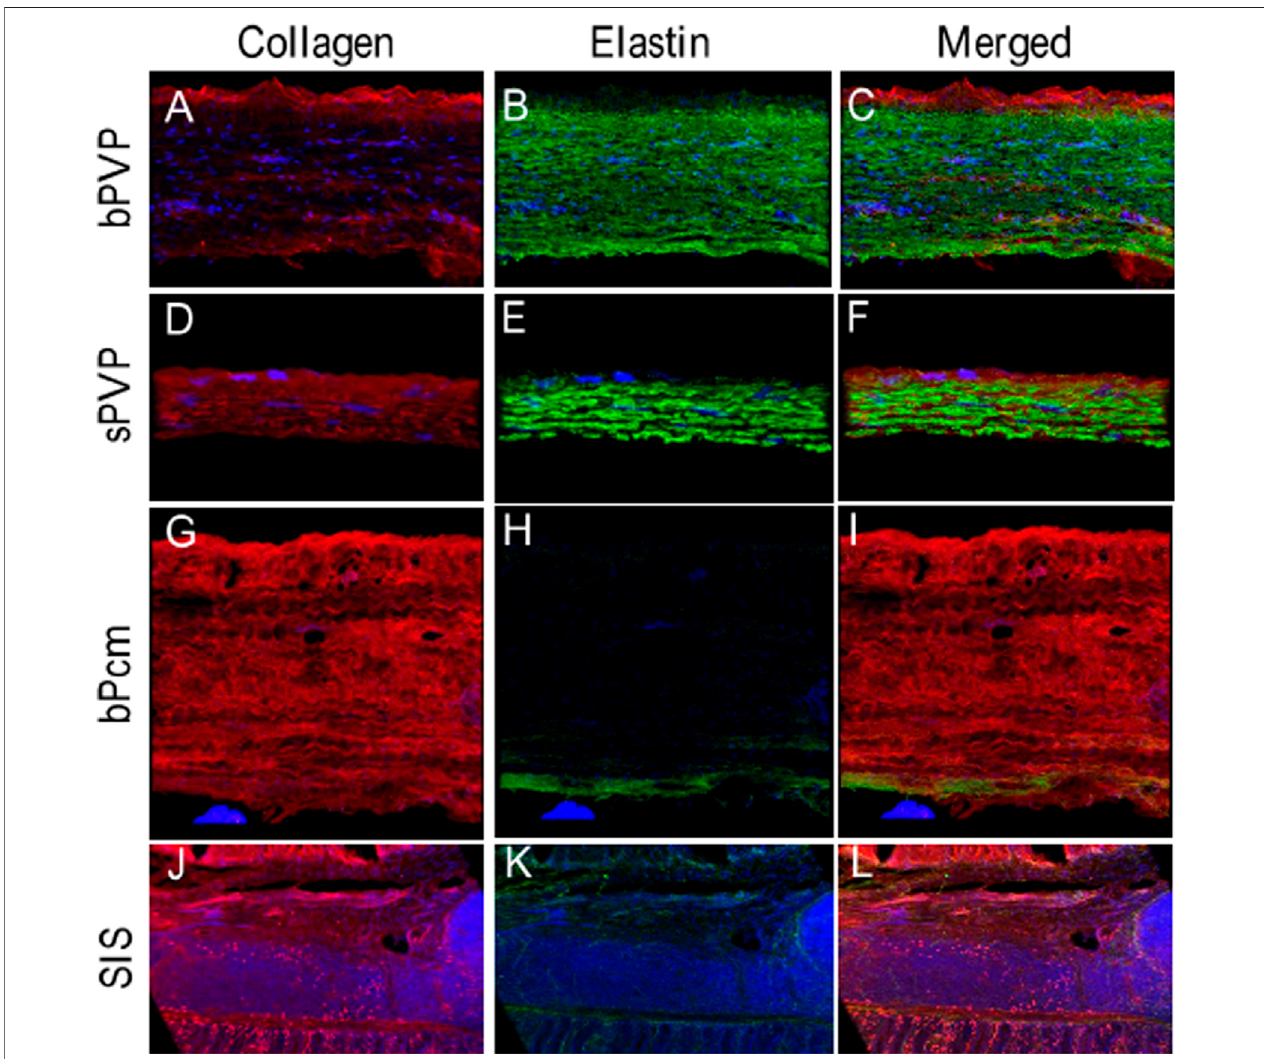
FIGURE 2 | Collagen and elastin fi bers in bPVP, sPVP, bPcm, and SIS. (A – C) Collagen, elastin, and merged collagen and elastin in bPVP, respectively. (D – F) Collagen, elastin, and merged collagen and elastin in sPVP, respectively. (G – I) Collagen, elastin, and merged collagen and elastin in bPcm, respectively. (J – L) Collagen, elastin, and merged collagen and elastin in SIS. Red: anti-collagen; green: anti-elastin; blue: nuclei. Objective: ×60.